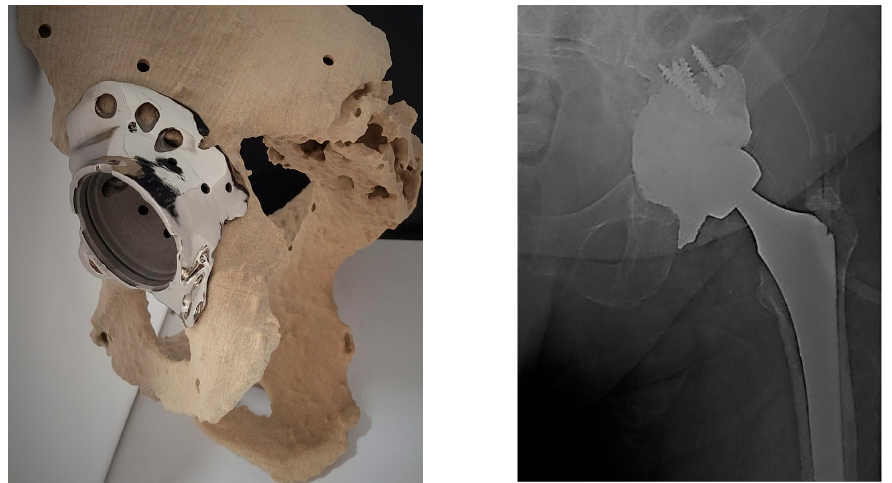
Figure 5. A 3D printed custom-made prosthesis designed to address an acetabular defect of a patient and mounted on the 3D printed model of the patient’s pelvis (left), together with an x-ray of its implantation (right).